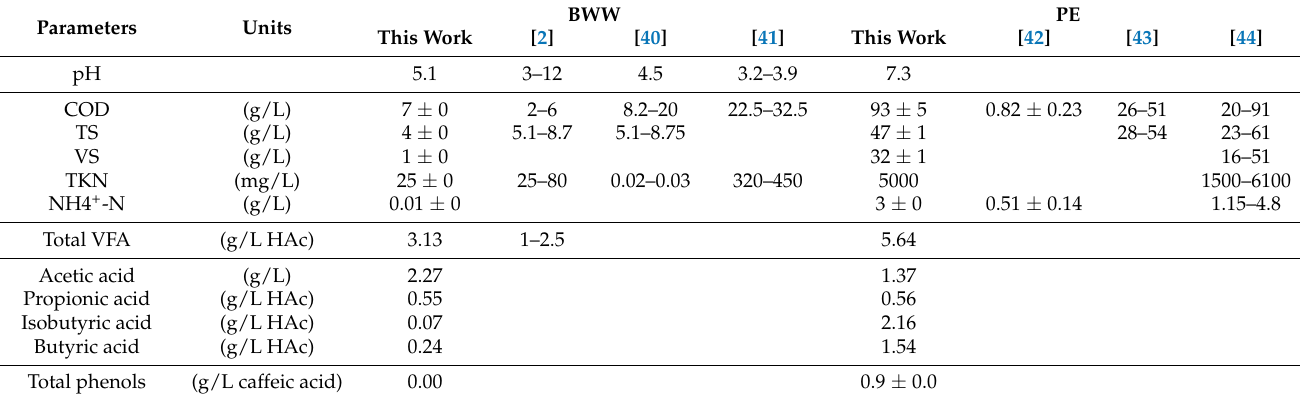
Table 2. Chemical composition of